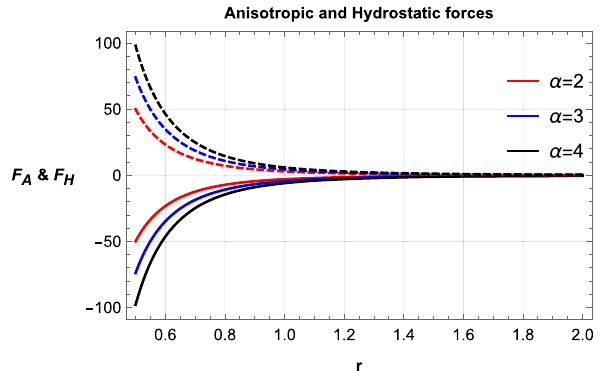
Fig. 18 Hydrostatic (plane lines) and anisotropic (dashed lines) forces for parallel cylinder with r 0 = 0 . 5